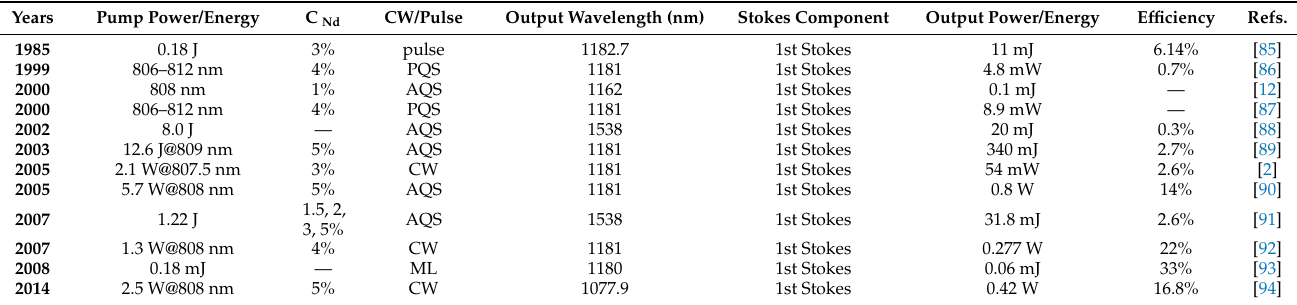
Figure 4. Schematic of the first continuous-wave self-Raman laser [2]. Table 7. Research progress on Nd:KGW self-Raman